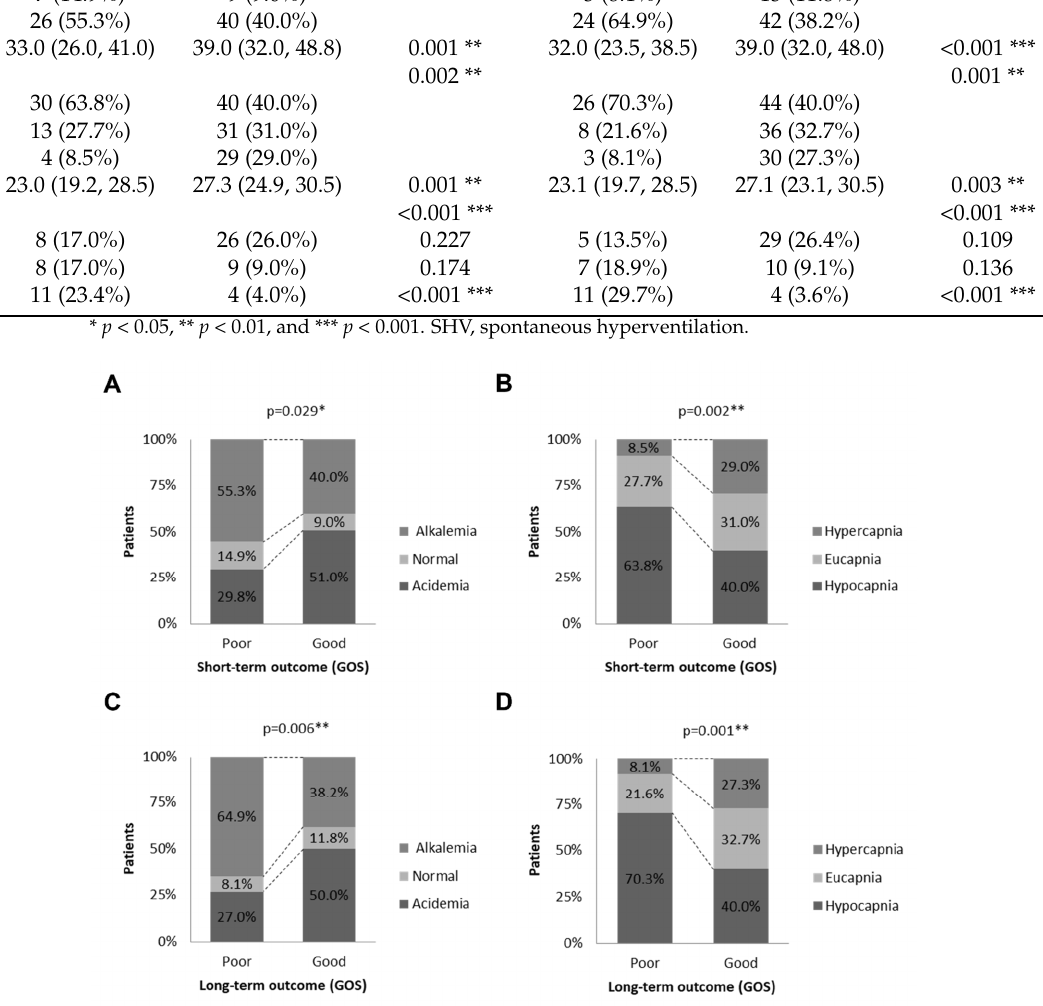
Figure 2. Neurologic outcome of patients was assessed by Glasgow Outcome Scale (GOS) score. ( A , C ), the association of acid–base balance with the short-term and long-term outcome. ( B , D ), the association of blood carbonic acid level with the short-term and long-term outcome. * p < 0.05, ** p < 0.01 When the ABG results were analyzed according to SHV severity, an interesting con- clusion was drawn whereby SHV severity was associated with outcome ( p < 0.001). In patients with poor short-term outcomes, 8(17.0%) patients had mild SHV, 8 (17.0%) pa- tients had moderate SHV, and 11 (23.4%) patients had severe SHV. In patients with good short-term outcomes, 26 (26.0%) patients had mild SHV, 9 (9.0%) patients had moderate SHV, and 4 (4.0%) patients had severe SHV. In patients with long-term outcomes, the amounts were 5 (13.5%) patients, 7 (18.9%) patients, and 11 (39.7%) patients for poor out- comes and 29 (26.4%) patients, 10 (9.1%) patients, and 4 (3.6%) patients for good outcomes. SHV severity showed a significant difference in the poor and good outcome groups (Fig- ure 3), especially severe SHV ( p < 0.001) (Table 3).